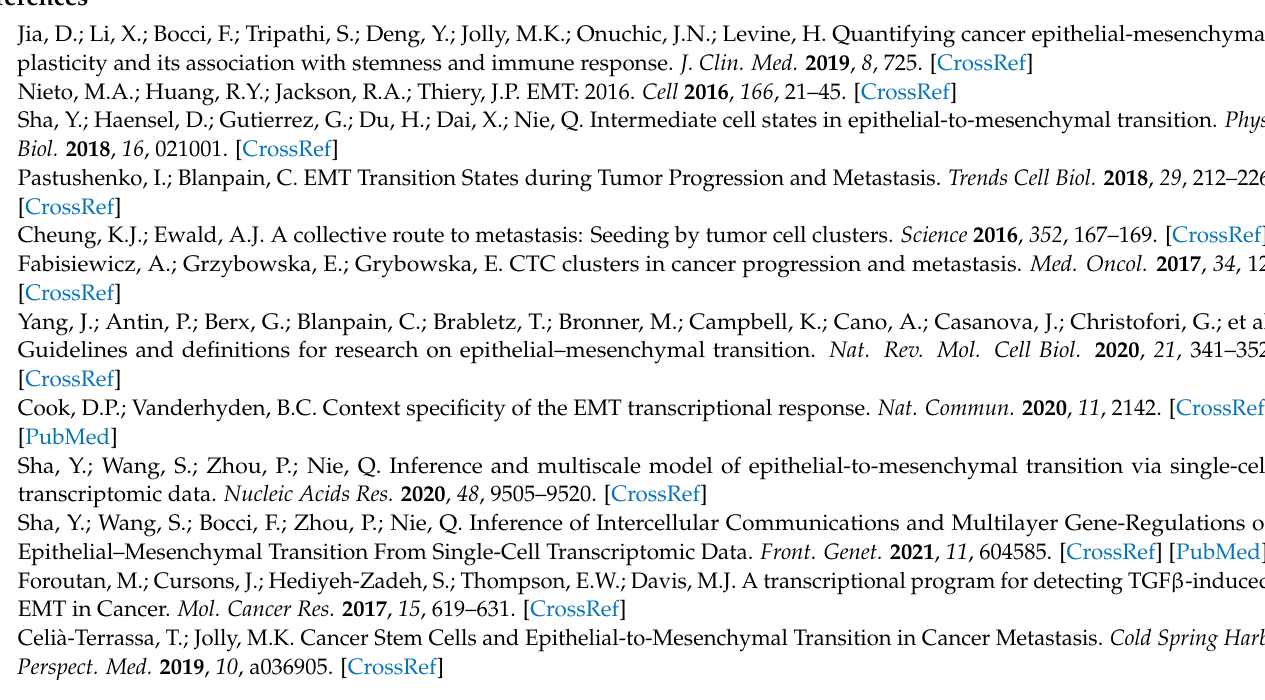
Figure S10: Cellchat analysis of HNSCC cells. Table S1: List of upregulated and downregulated EMT genes. Table S2: EMT paths identified by